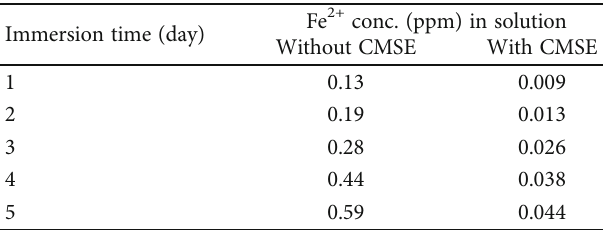
Table 11: Fe 2+ concentration loss during corrosion experiments with and without